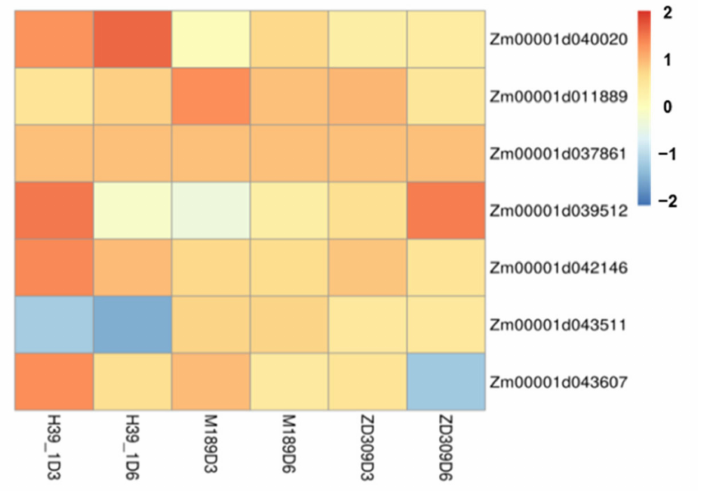
Figure 8. The relative expression levels of 7 fructose and mannose metabolism-related genes in the tested three plant materials. Data are presented as heatmaps of a log 2 transformed fold